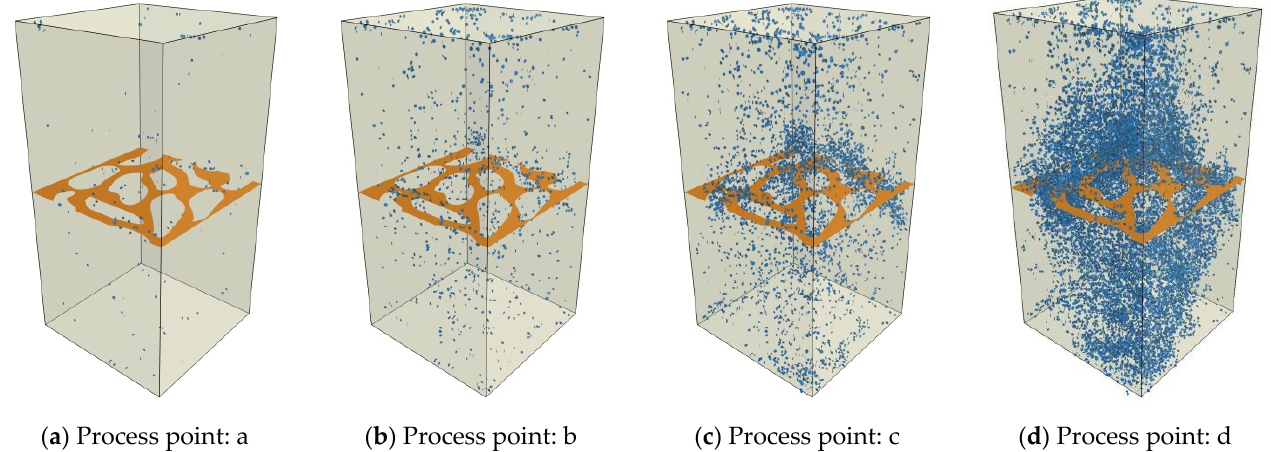
Figure 10. Microcrack development in specimen S − 0 − K1.